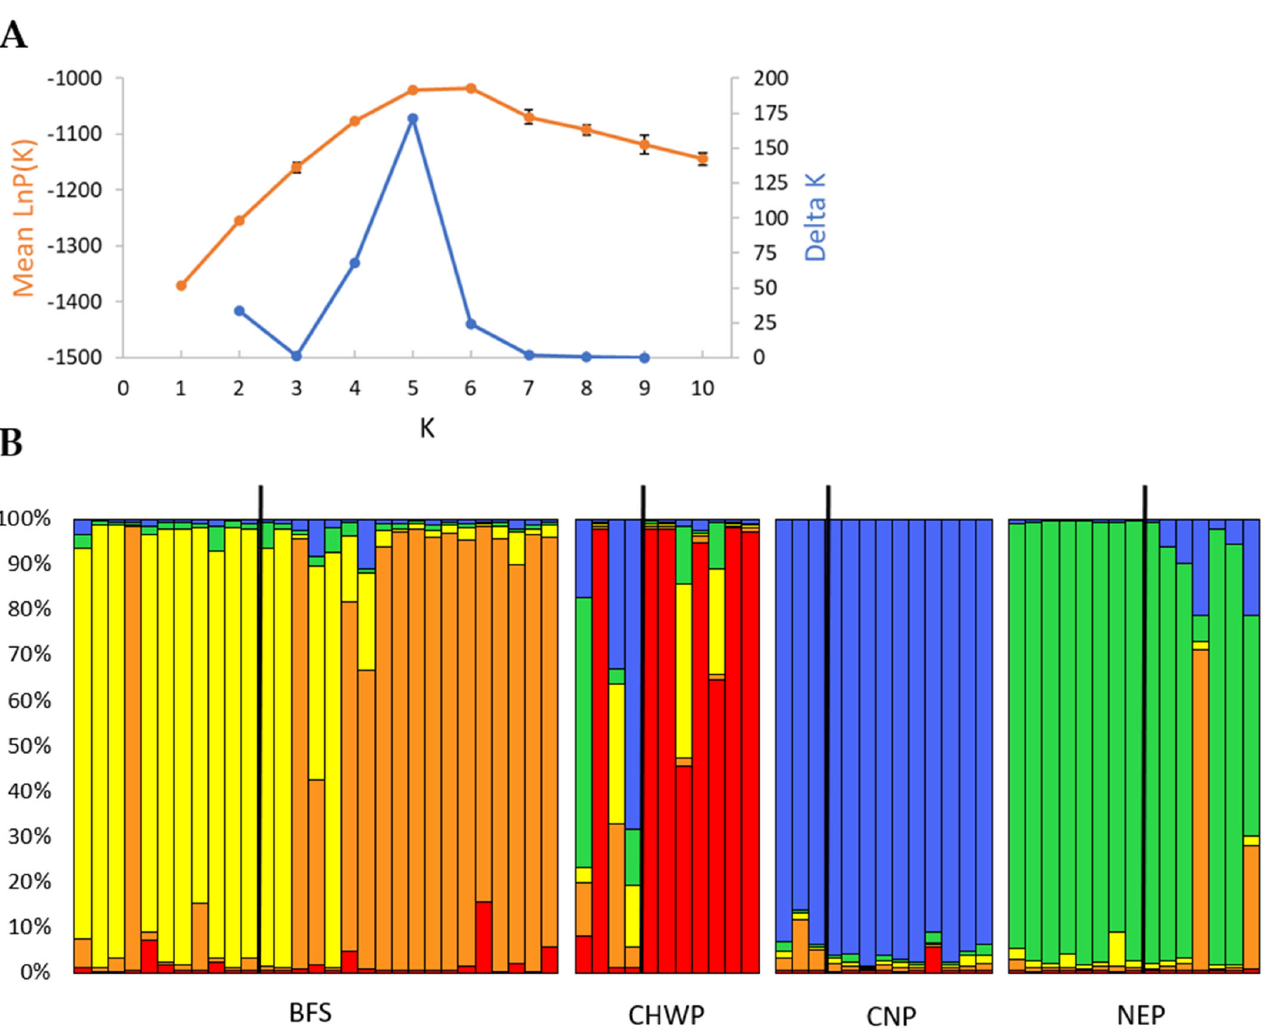
Figure 2. ( A ) Evanno plot from STRUCTURE analysis showing that K = 5 is the best − fit model of our data. Orange line shows mean log-likelihood probability of each K value and blue line shows delta K values. ( B ) Genetic assignments from STRUCTURE analysis with five genetic clusters. Plot is aligned and averaged across 10 replicates. The fraction of color for each individual coyote (columns) represents the probability of assignment to that genetic cluster. Samples are sorted temporally by sample date within each sampling location. Black bars within sites separate sampling years 2017 and 2018. For coyotes sampled more than once, we retained the earliest sample with the most complete genotype.